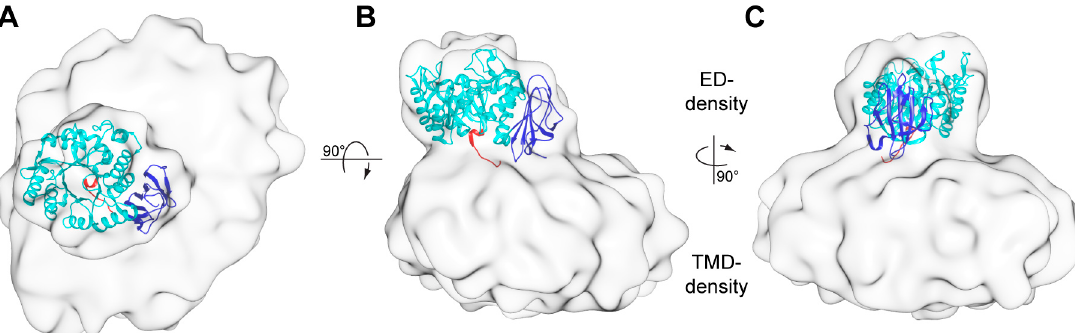
Figure 4. Cryo-EM 3D-map at a resolution of ~13 Å. The 3D-map is displayed as viewed from the extracellular side ( A ) and from the membrane plane ( B , C ). The 3D-map is composed of two densities. The smaller and the larger densities are named ED- and TMD-density, respectively. The structure of the 4F2hc-ED (PDB ID code 2DH2, [6]) was fitted into the ED-density and is shown as ribbon model. The 4F2hc-ED structure is composed of an N-terminal region (red), a TIM-barrel subdomain (cyan), and a C-terminal eight antiparallel β -strand subdomain (blue). The N-terminus (red) also reflects the approximate location of the disulfide bridge between 4F2hc and LAT2. All 3D-maps are equally scaled and the scale bar in panel C represents 100 Å.